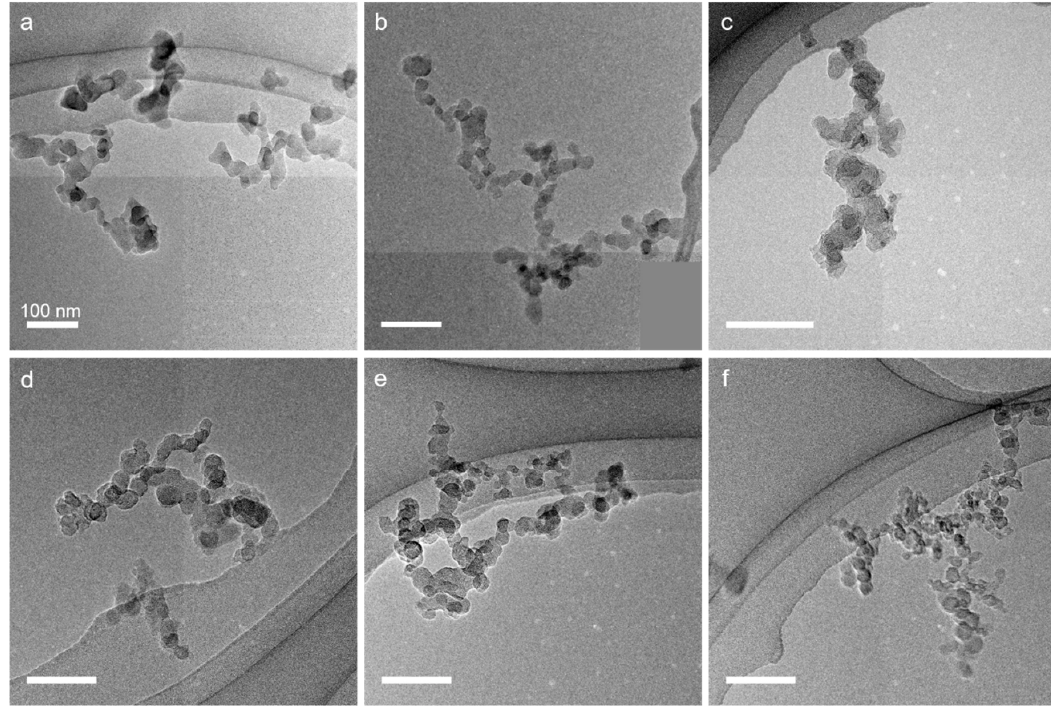
Figure 4. Representative TEM images of samples from diesel ( a – d ), HVO ( e ) and RME ( f ). The particles are sampled at di ff erent levels of exhaust gas recirculation (EGR), i.e., intake O 2 %; ( a ) 10, ( b ) 12, ( c ) 17, ( d ) 13, ( e ) 13 (HVO) ( f ) 13 (RME). Table 2. The geometric mean of the soot primary particle size measured from the TEM images, the estimated specific surface area (SSA), the mobility size of the aggregates (geometric mean diameter ±1 std. dev. in the time series) measured with the DMS and the average number concentration per gravimetric PM mass. The GSD for the primary particle size and SSA distributions were 1.32–1.50. For primary particle size and SSA, intervals in brackets represent the 95% confidence interval of the distribution parameters.